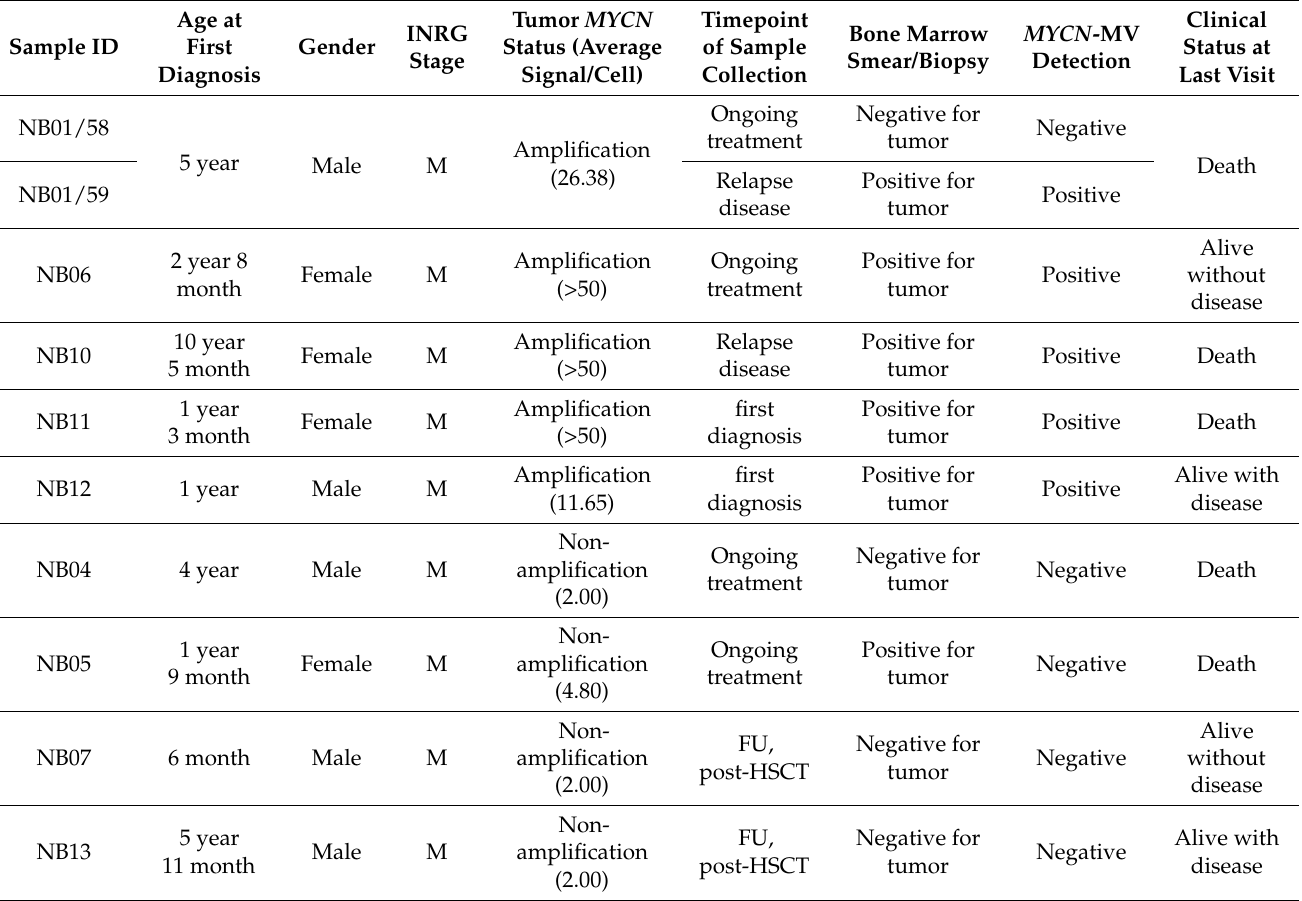
Table 1. MYCN-MV detection in 10 bone marrow plasma specimens obtained from nine neuroblas- toma patients.